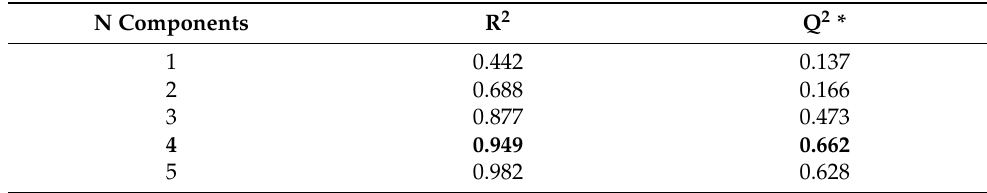
Table 4. Statistical characteristics of the PLS model used to select presumably active